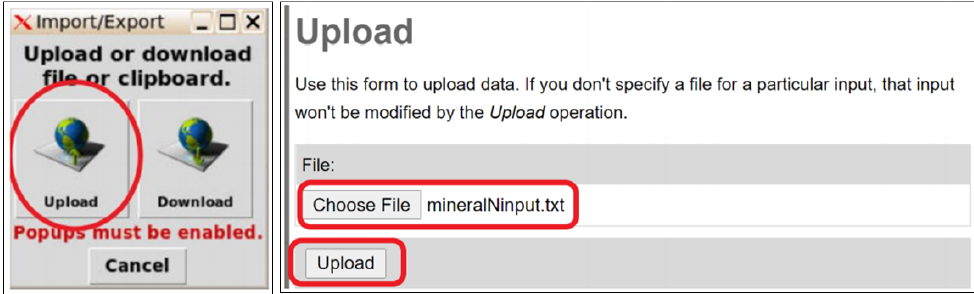
Figure 7. Screen grab of file upload window in MyGeoHub. ( Left ): Tool window to upload and download files between local computer and MyGeoHub user space. ( Right ): File browser to choose a local file to be uploaded to MyGeoHub.